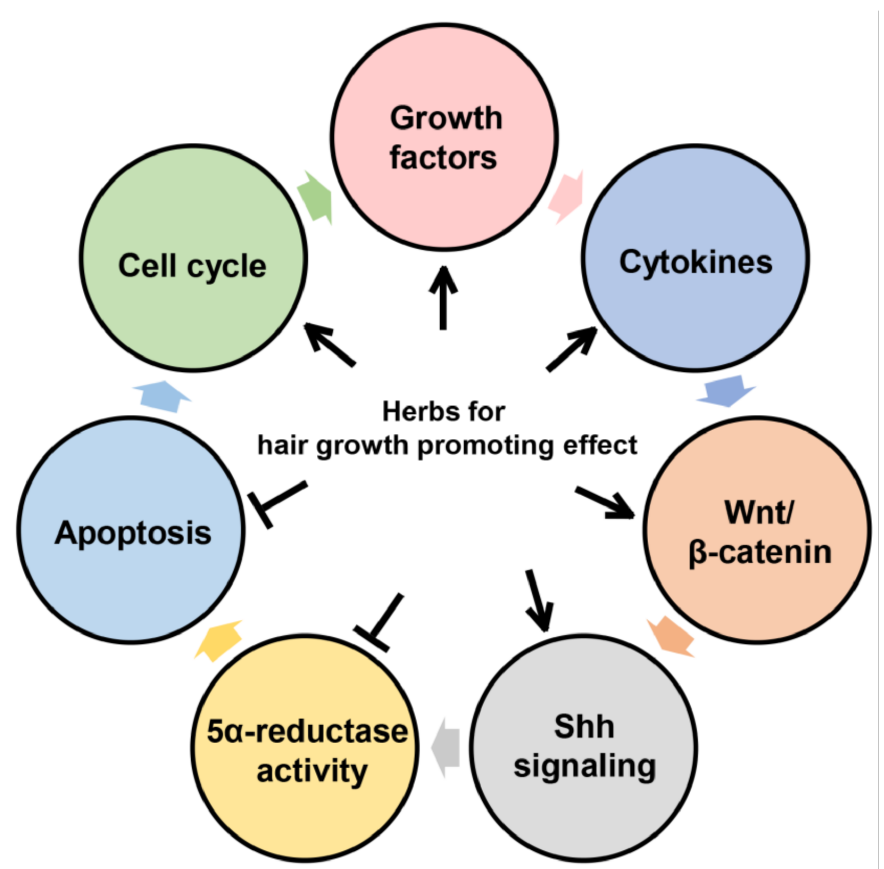
Figure 1. Interactions between herbs and their mechanisms for hair-growth-promoting